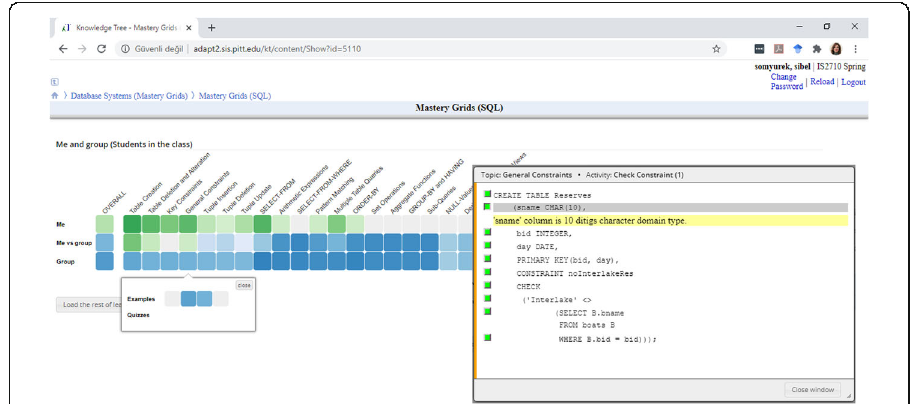
Fig. 1 The e-learning system interface To access a learning activity (a question or a work example), the students click on one of the content cells inside the selected topic. The figure shows a work example from a general constraints topic, which was opened by a student who is now examining comments in